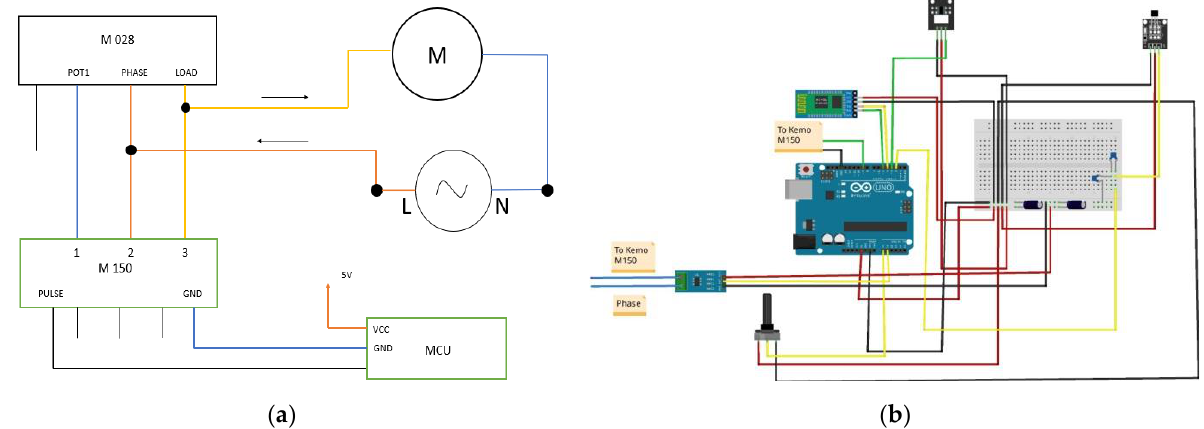
Figure 2. General diagrams: ( a ) overview of Kemo’s connections, ( b ) overview of Arduino’s and sensor’s connections .